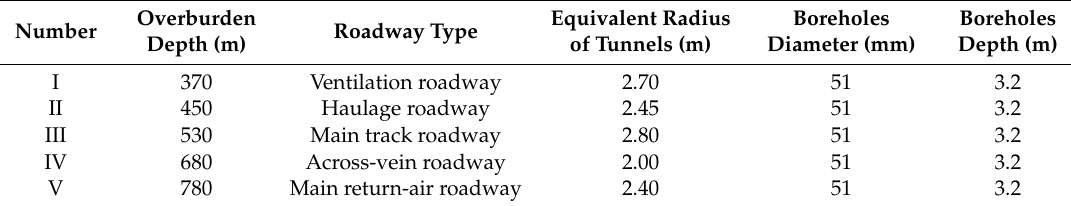
Table 2. Locations and parameters of five monitoring roadways.